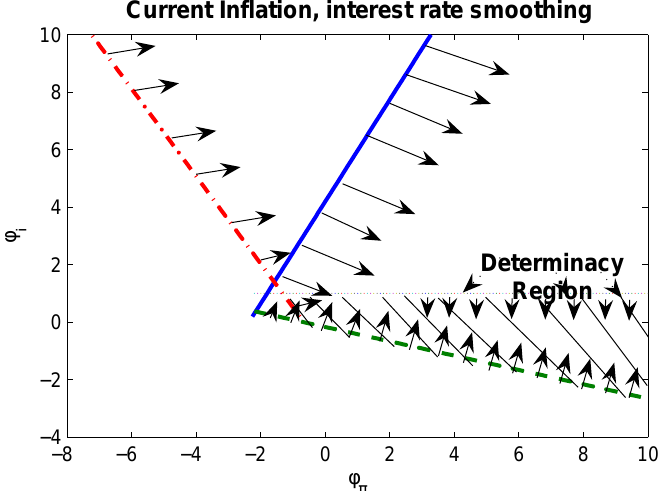
Figure 4. Determinacy regions for a Taylor rule with current inflation and interest rate